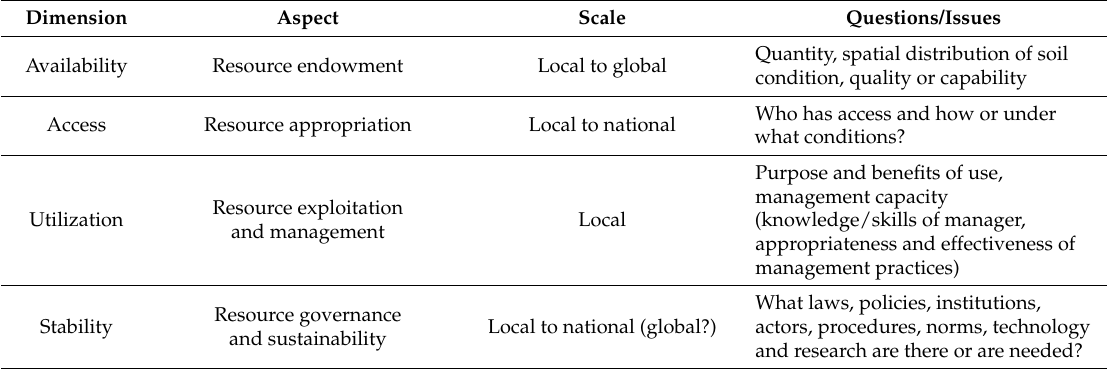
Table 1. Proposed dimensions of soil